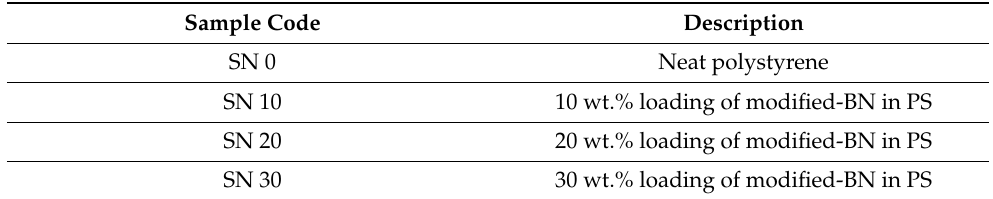
Table 1. Sample code details.